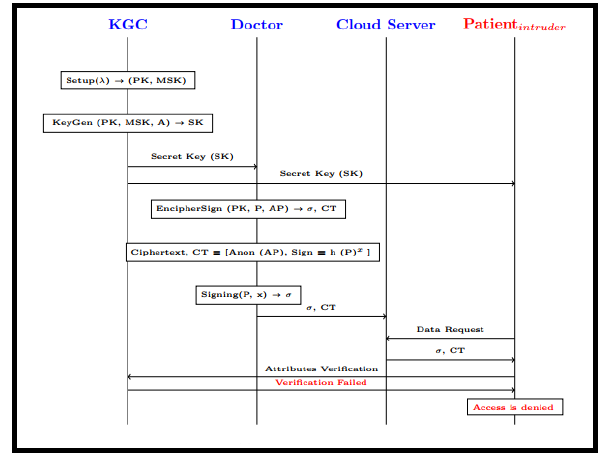
Figure 16. Threat model—mismatching of attributes.